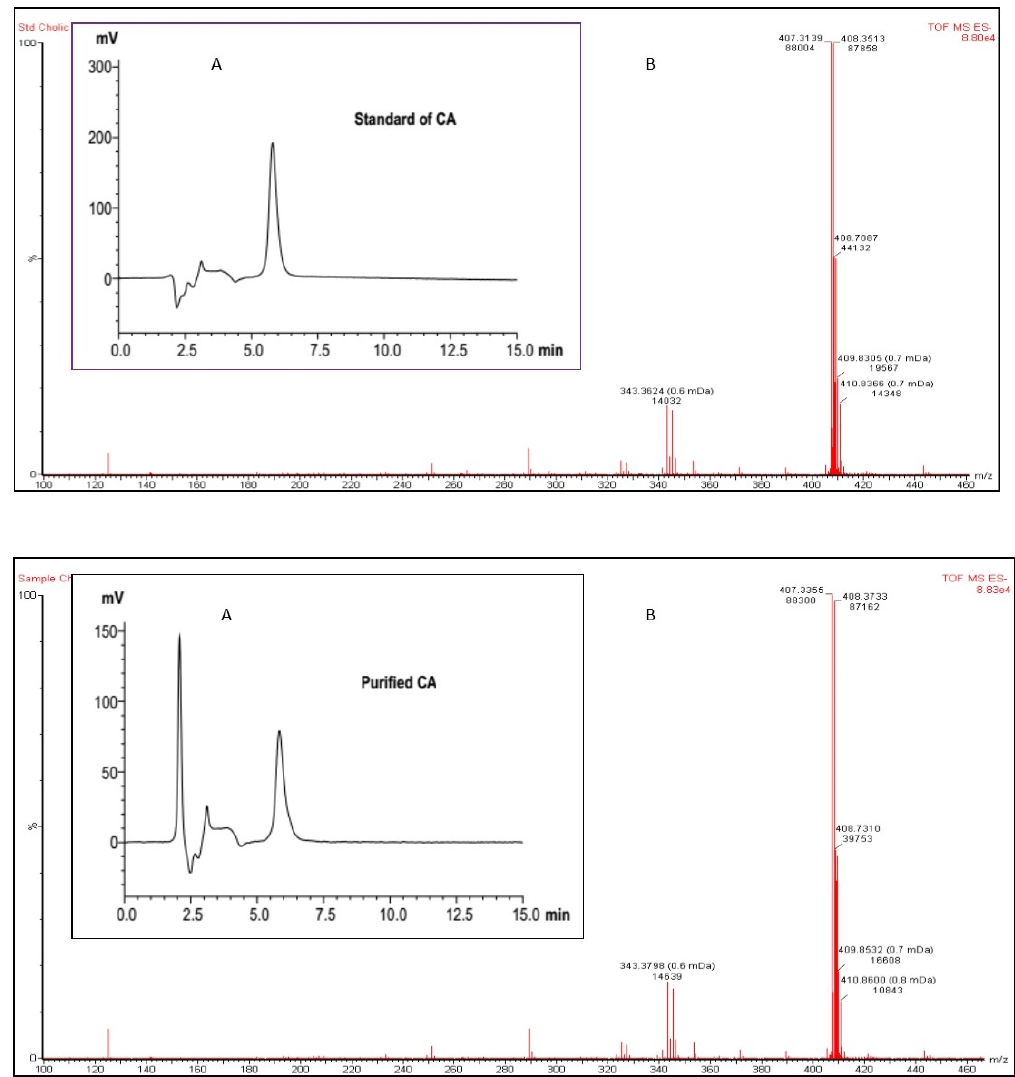
FIGURE 8 - Confirmation of the purity of CA with the HPLC (A) and product ion scan of CA in negative ion mode resulting in a parent ion [M-H]- at m/z 407.3 and one of daughter ions at m/z 343.3 (B). For the HPLC, the mobile phase consisted of 30% acetonitrile containing 0.3% ammonium carbonate. Samples were CA standard (upper) and the isolated CA